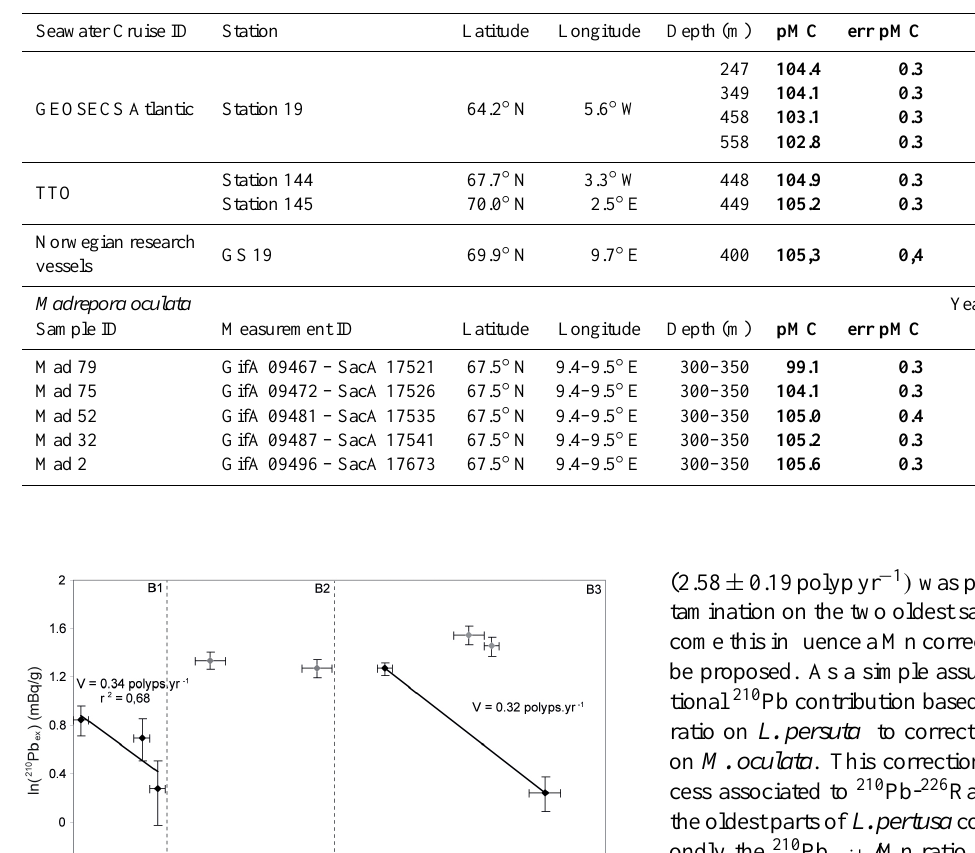
Table 3. Radiocarbon data from the Madrepora oculata specimen and from dissolved inorganic carbon of water collected nearby the area of coral growth. In bold is noted the radiocarbon data expressed as pMC. The lower and upper limit of growth year was estimated by adjusting the data of M. oculata and those of seawater considering a linear growth.